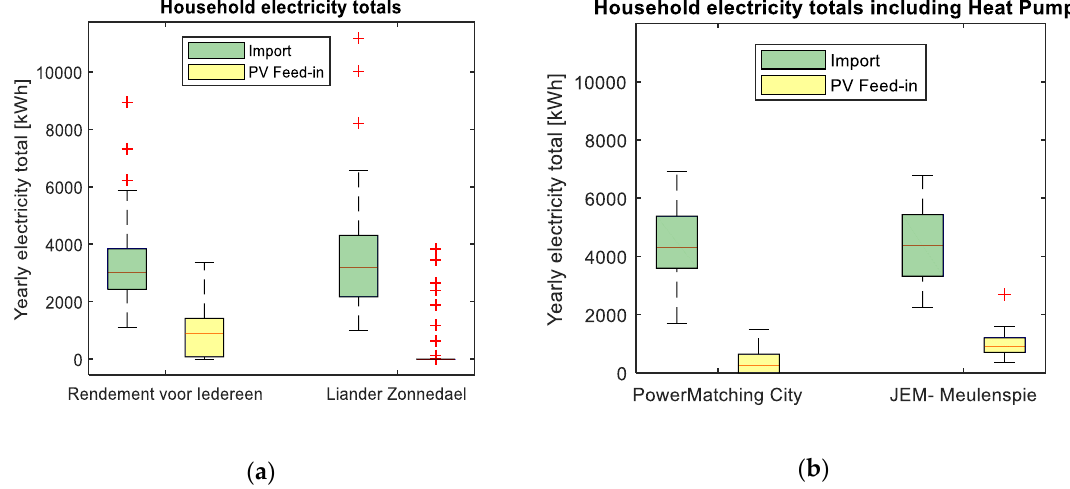
Figure 4. Boxplots of annually imported electricity from the grid and surplus PV (feed-in) to the grid for ( a ) household without heat pumps and ( b ) households with heat pumps. For each box, the red line indicates the median, and the bottom and top edges of the box indicate the 25th and 75th percentiles, respectively. The whiskers extend to the most extreme data points without considering the outliers, and the outliers are plotted individually in red.